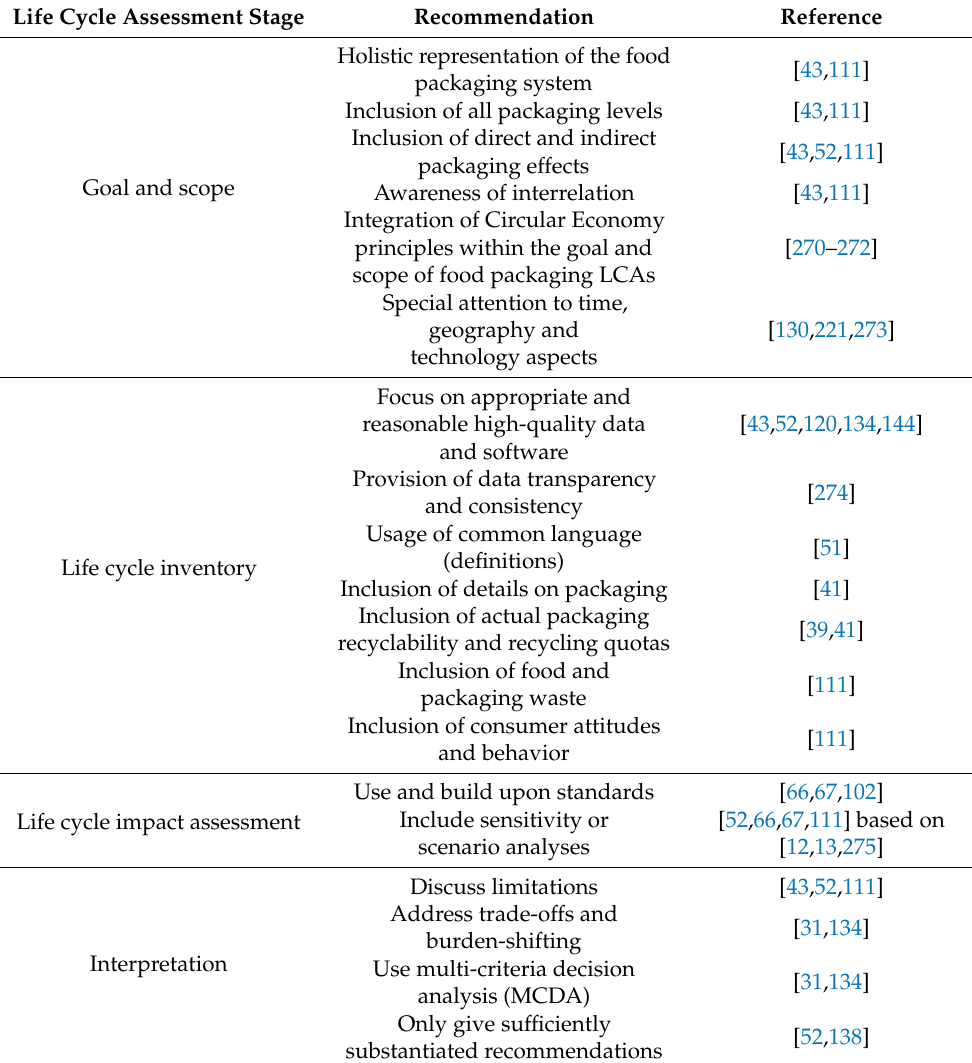
Table 4. Recommendations for improving food packaging life cycle assessments (LCAs) based on the structure given by